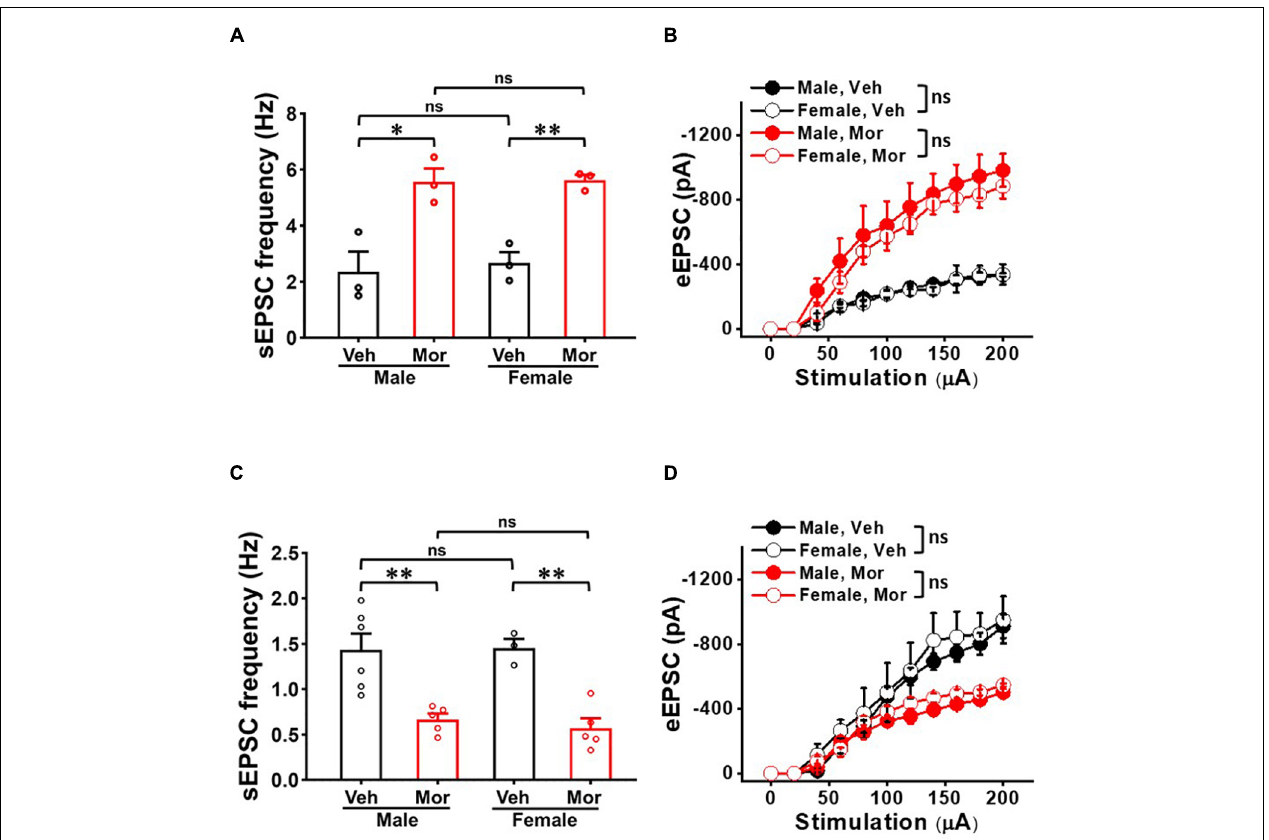
FIGURE 6 | No gender effect on the repeated morphine-induced synaptic strength in SDH. (A) sEPSC frequency [effect size: 0.31, p = 0.728; Veh: Male ( N = 3, n = 20) vs. Female ( N = 3, n = 9) and effect size: 0.08, p = 0.930; Mor: Male ( N = 3, n = 25) vs. Female ( N = 3, n = 29)] and (B) eEPSC (Veh: Male ( N = 3, n = 15) vs. Female ( N = 3, n = 7); Mor: Male ( N = 3, n = 8) vs. Female ( N = 3, n = 13) in non-tonic firing neurons. (C) sEPSC frequency (Veh: Male ( N = 6, n = 97) vs. Female ( N = 3, n = 46); effect size: 0.05, p = 0.929 and Mor: Male ( N = 7, n = 66) vs. Female ( N = 3, n = 53); effect size: –0.02, p = 0.874) and (D) eEPSC (Veh: Male ( N = 3, n = 19) vs. Female ( N = 3, n = 13), F ( 1 , 6 . 09 ) = 0.41, p = 0.544. Mor: Male ( N = 3, n = 19) vs. Female ( N = 3, n = 13), F ( 1 , 6 . 09 ) = 0.41, p = 0.544) in sGABAn. ∗ p < 0.05 or ∗∗ p < 0.01; Welch’s t test. ns: not significant. Sidak’s multiple comparison test following multilevel analysis. Veh: Vehicle, Mor: Morphine.